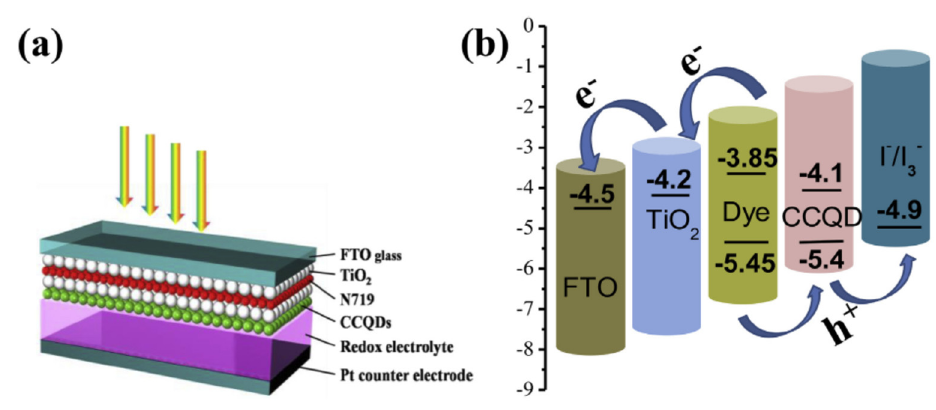
Figure 13. ( a ) Schematic diagram of a mesoscopic solar cell tailored with CCQDs and N719 dye. ( b ) The energy level distribution and charge transfer within the photoanode. Reprinted with the permission of Reference [109]. Copyright 2018 Elsevier Ltd.